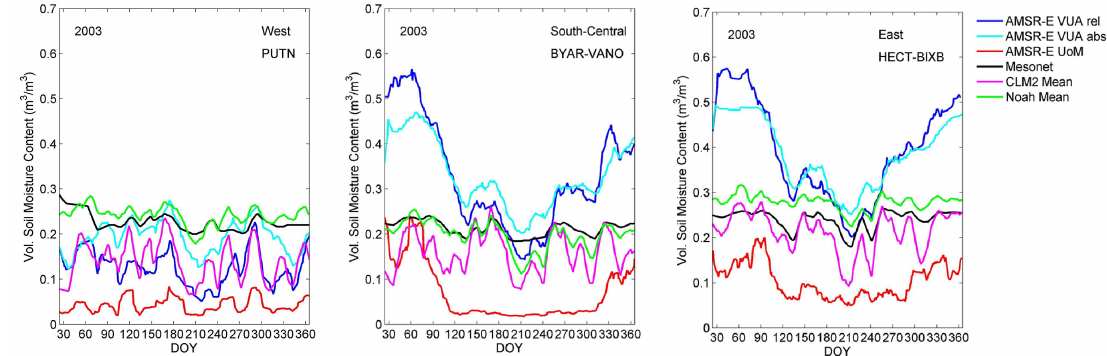
Fig. 2. AMSR-E derived, ground-observed and simulated soil moisture for 0.25 ◦ grid cells in the Western (PUTN), South-Central (BYAR- VANO) and Eastern Oklahoma area (HECT-BIXB) (low-pass filter 14